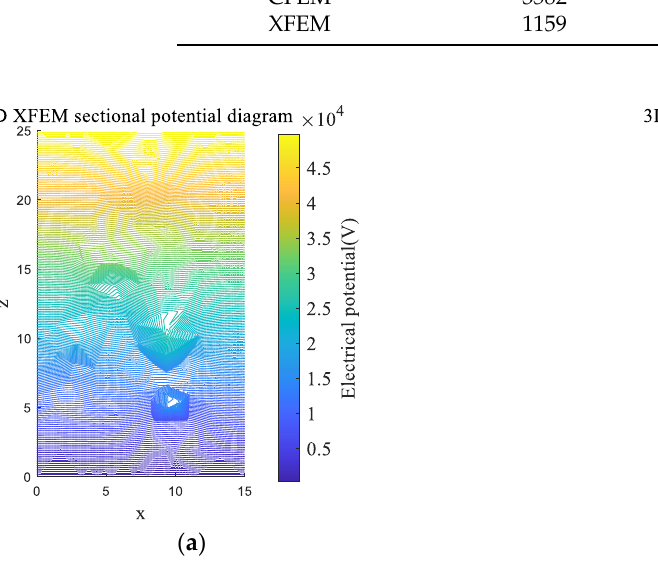
Among the 1159 nodes, the maximum relative error is 7.93% and the average relative